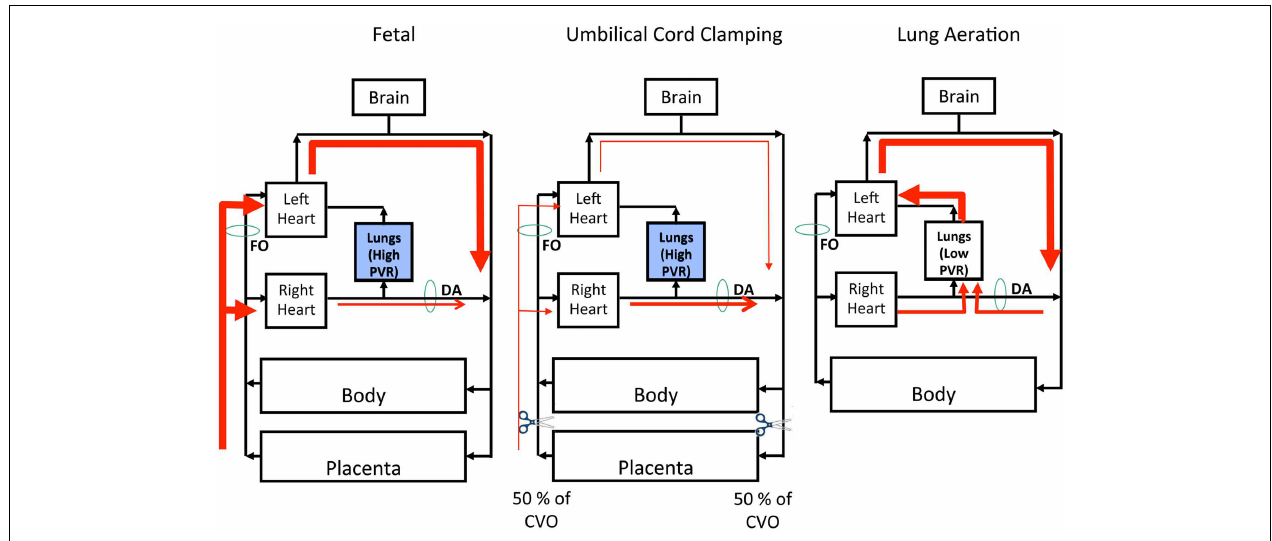
ventricular output (CVO) by ~50%. Since the lungs are still filled with fluid, PVR is high thus right ventricular output is still diverted away from the pulmonary circulation, through the DA. Right Panel: Removal of lung liquid and aeration of the lung results in a rapid fall in PVR and a subsequent increase in PBF, allowing 100% of right ventricular output to enter the lungs. This allows the pulmonary circulation to replace the placenta as the source of left ventricular output.There is also a reversal in pressure gradient and thus direction of blood flow across the ductus arteriosus (from left-to-right to right-to-left), allowing for up to 50% of left ventricular output to enter the pulmonary circulation, thus further stabilizing the upper body